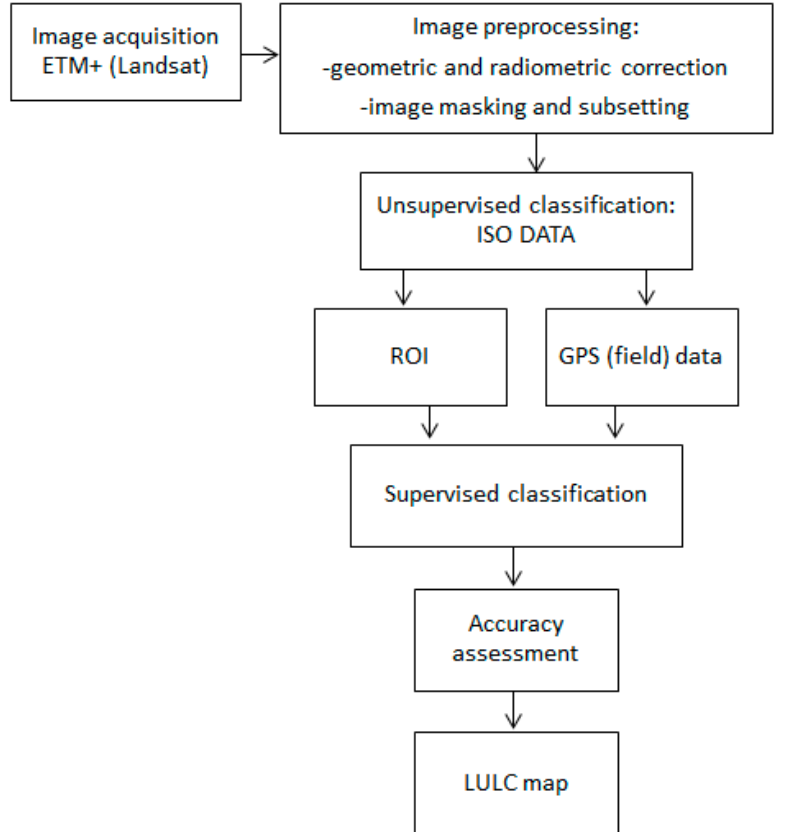
Figure 2. Satellite image processing flow chart for Land Use Land Cover ((LULC)) map preparation